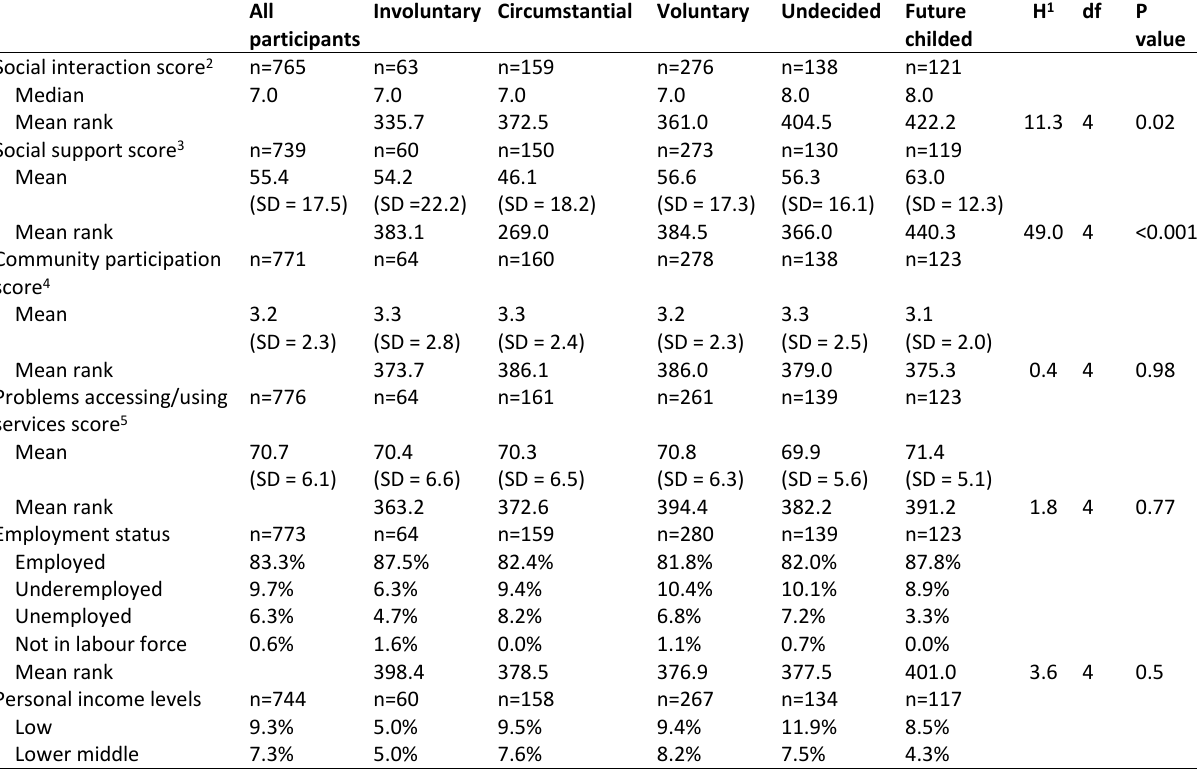
Table 3. Indicators of exclusion in the social, civic, service and economic